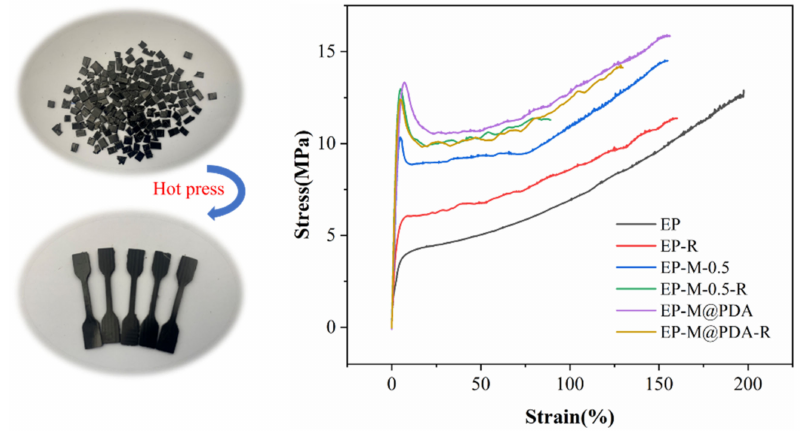
Figure 15. Typical stress–strain curves of virgin and reprocessed epoxy